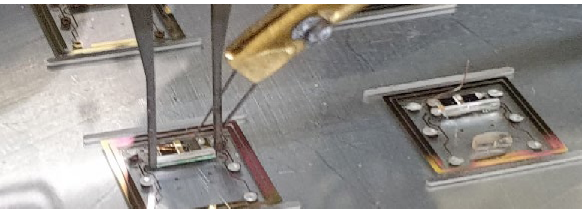
Fig. 3: Automated assembly of small (9x9x0.7) mm 3 laser pack- ages with appropriate lenses and optical edge windows on panel before stacking, hermetic sealing, and subsequent singulation by means of laser